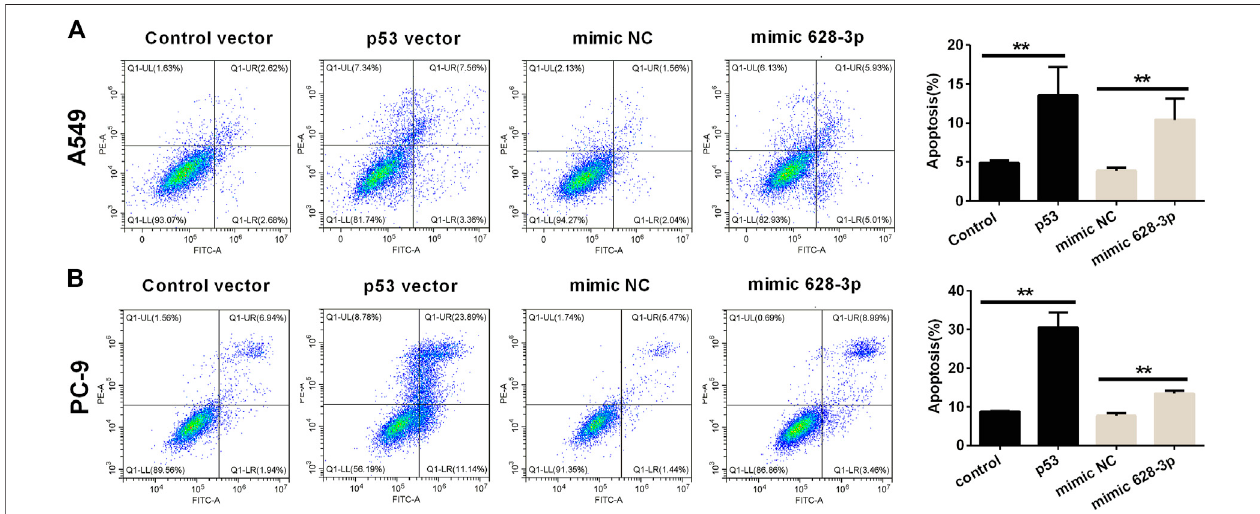
FIGURE5| EffectsofoverexpressionofmiR-628-3pand p53 on apoptosis ofA549and PC-9 cells. (A) A549and (B) PC-9 cellsweretransfected with p53vector or control vector or mimic 628-3p or mimic NC, and the apoptosis was detected by fl ow cytometry 24 h later. All measurements were carried out in triplicates, and data are given as mean ± SD ( n (cid:2) 3). ** p < 0.01, comparing with control vector or mimic